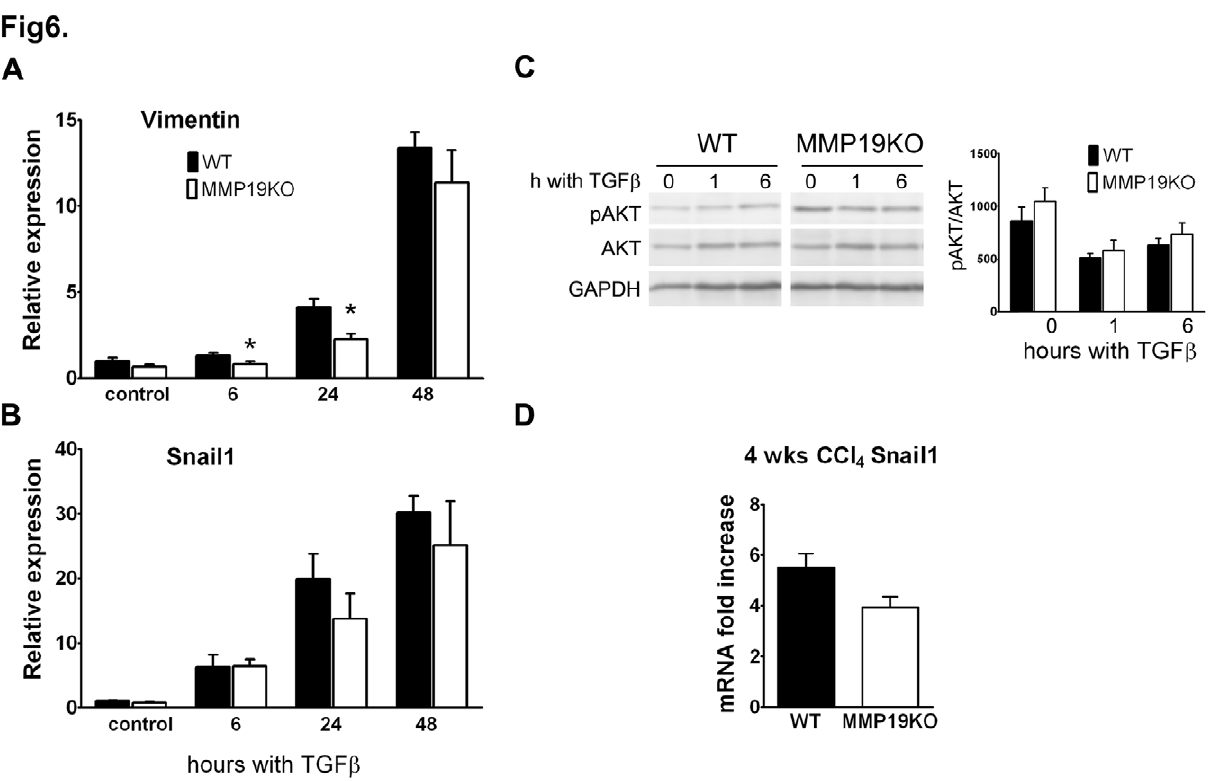
Figure 6. Isolated hepatocytes from MMP19KO livers show impaired responsiveness to treatment with TGF-ß1. Primary hepatocytes were isolated from WT and MMP19KO livers, seeded on collagen I and stimulated with TGF-ß1. (A, B) mRNA levels of vimentin and Snail1 were measured in control, untreated hepatocytes, and hepatocytes stimulated with TGF-ß1 for 6, 24, or 48 h. (C) Phosphorylation of Akt was slightly increased in MMP19KO compared to WT hepatocytes. Noncontiguous lanes from one Western blot are shown. n=5 different hepatocyte isolations from both WTs and MMP19KOs. (D) mRNA levels of Snail1 in livers from animals treated with CCl 4 for 4 weeks showed slightly lower expression of Snail1 in MMP19KOs than in WTs. 4–7 mice from each strain were analyzed for each time point. *p , 0.05 MMP19KOs vs.